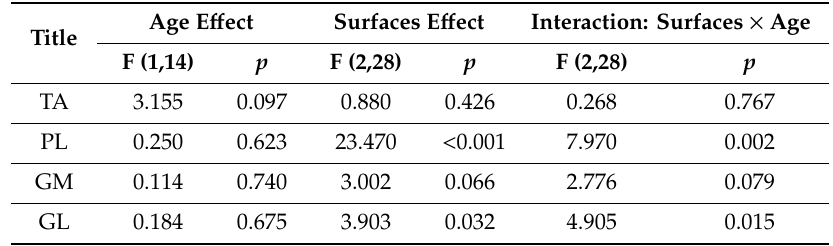
Table 1. Main e ff ects and interaction of the analysis of Table 1. Main effects and interaction of the analysis of variance.